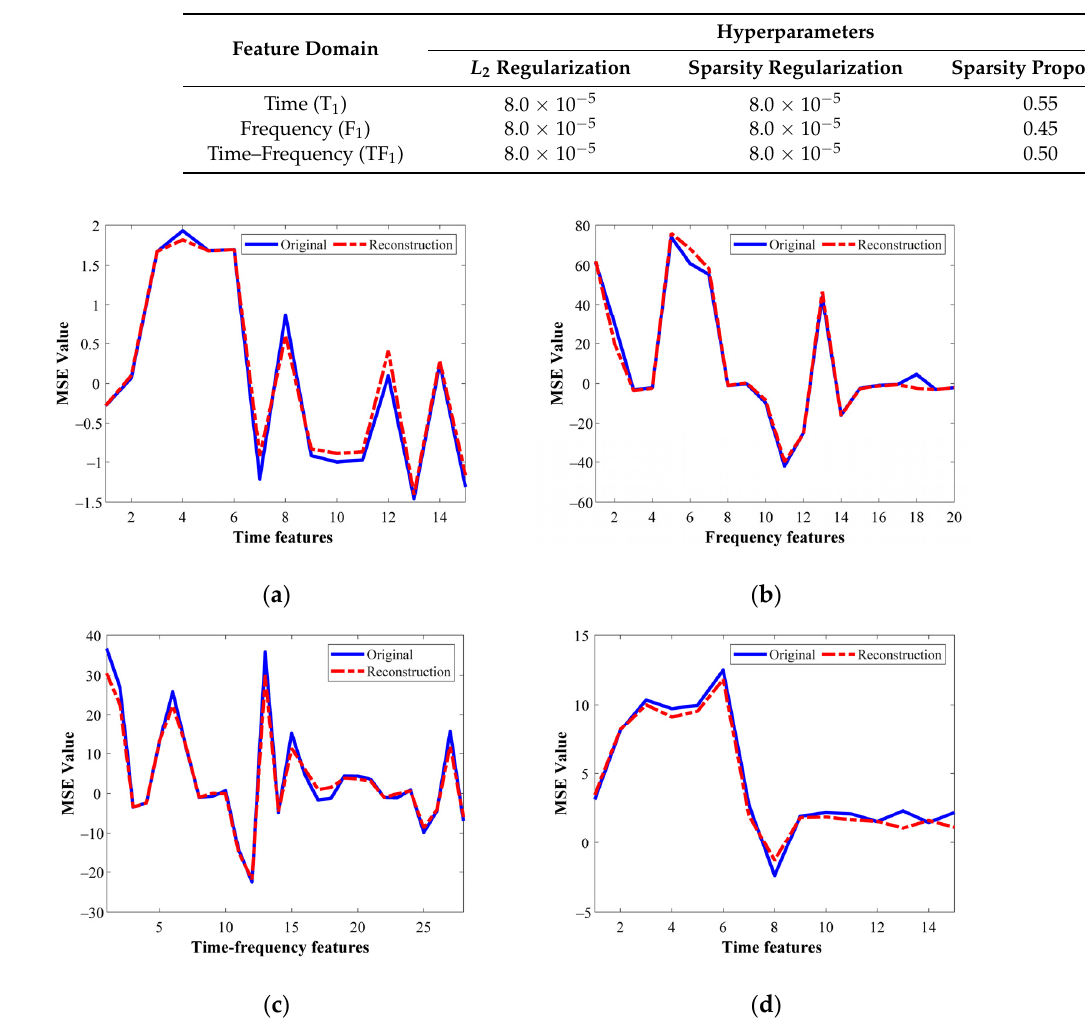
Figure 12. Comparison between the input feature patterns and its corresponding reconstruction obtained using the deep SAE-based feature extraction model on: ( a ) the NC represented in TD, ( b ) IF represented in TFD, ( c ) OF represented in TD and ( d ) OF represented in FD.